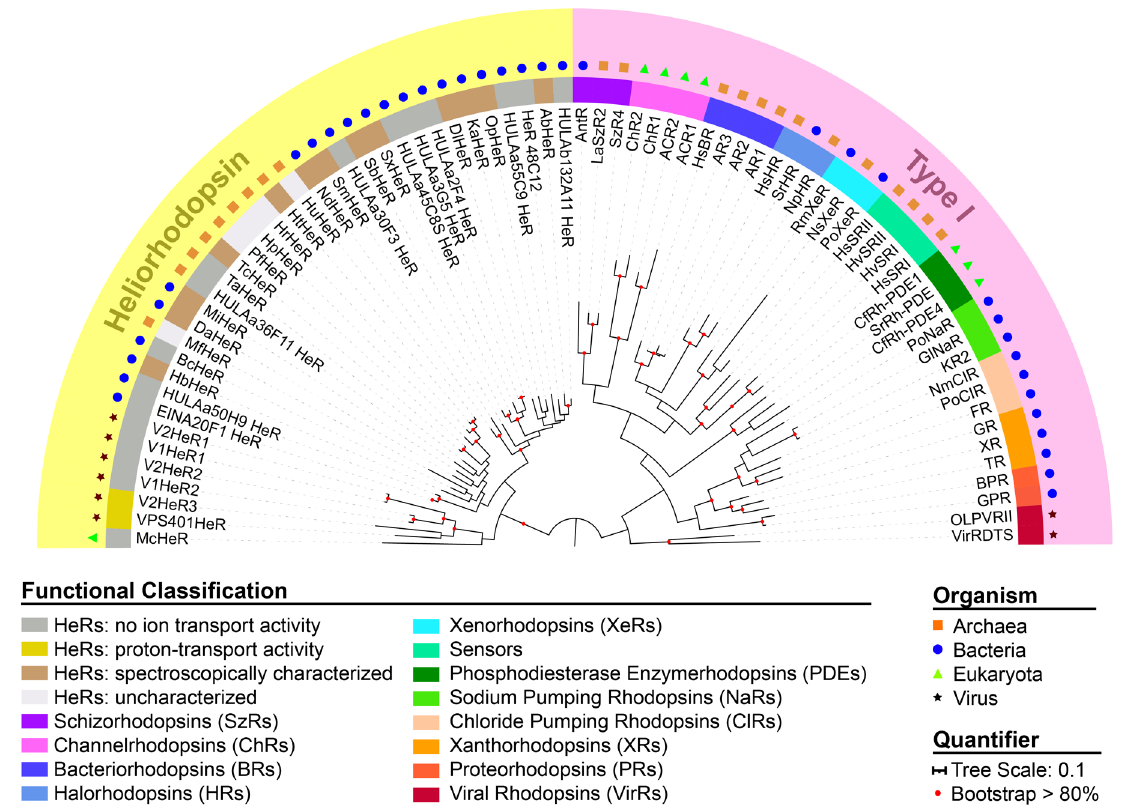
Figure 1. Phylogenetic tree of microbial rhodopsins with representative HeRs and type I rhodopsins. HeRs and type I rhodopsins form distinct branches arising from < 15% sequence identity. Microbial rhodopsins are widely distributed among archaea (orange squares), bacteria (blue circles), eukaryota (green triangles), and viruses (black stars). Type I rhodopsins have numerous diverse functions including outward H + pumps (BRs, XRs, PRs, VirRs), inward H + pumps (XeRs, SzRs), outward Cl – pumps (HRs, ClRs), outward Na + pumps